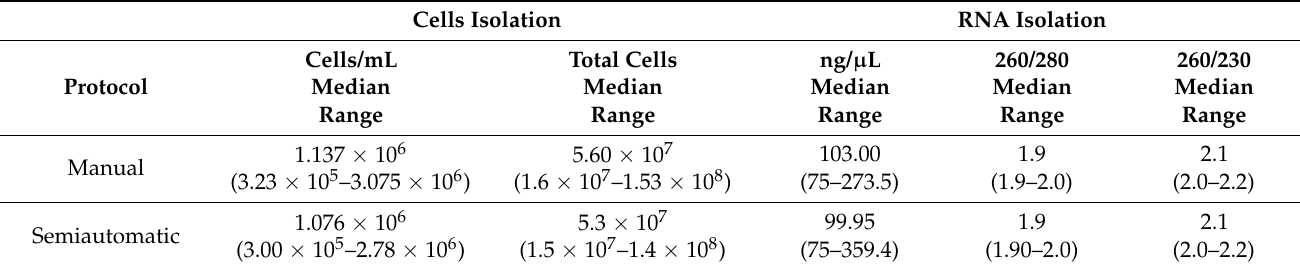
Table 3. Specification of white blood cell sand RNA isolation